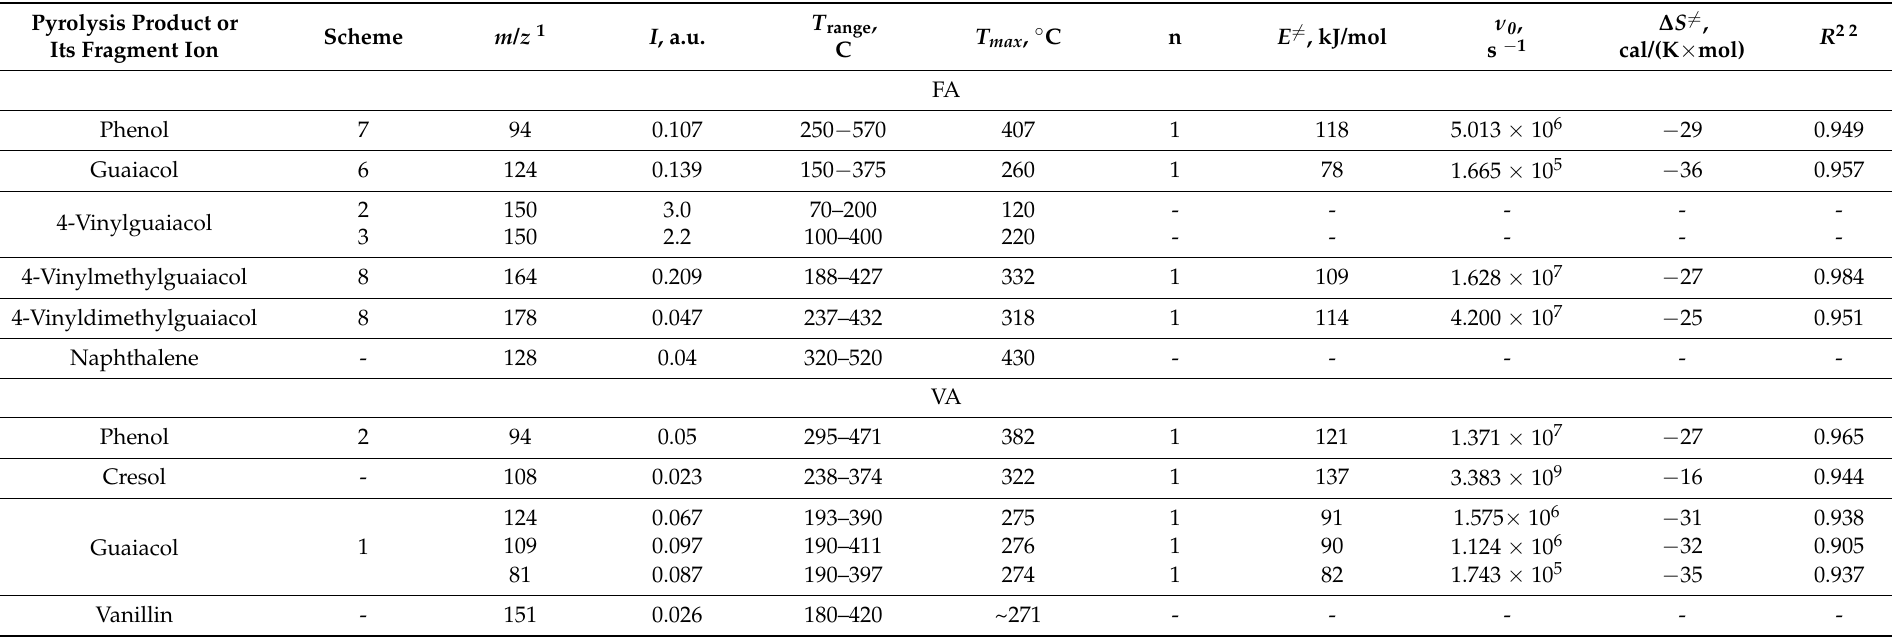
Table 9. Kinetic parameters (temperature of the maximum desorption rate T max , reaction order n , activation energy E (cid:54) = , pre-exponential factor ν 0 , and change of activation entropy ∆ S (cid:54) = ), temperature range (T range ) of formation and peak intensities (I) of the catalytic reactions of vanillic and ferulic acids during pyrolysis over nanoceria